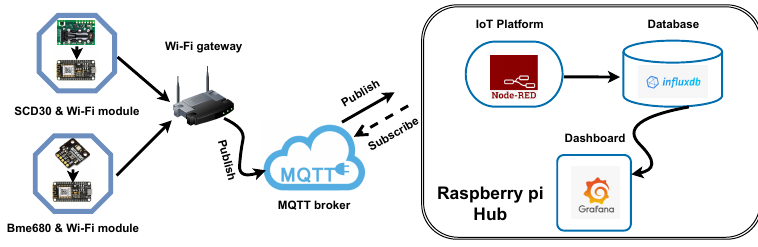
Figure 1. Architecture of our deployed IAQ monitoring